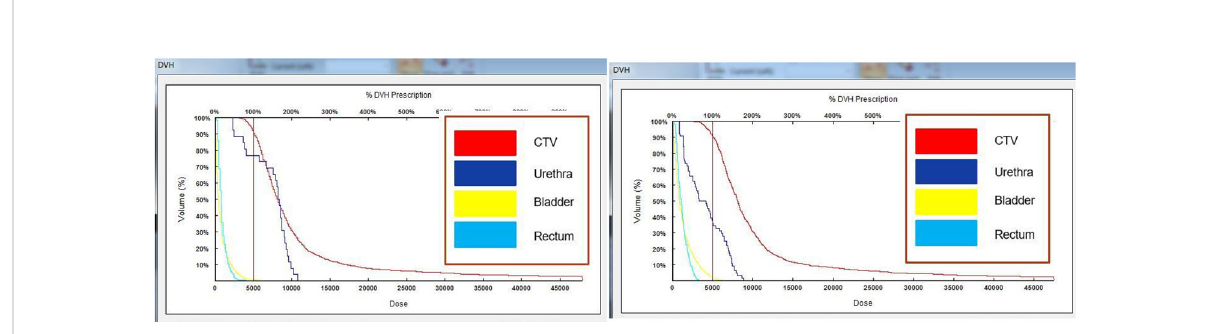
FIGURE 6 DVH plots before and after surgery. Comparison of the plots indicated that the postoperative dose parameters met the requirements of the preoperative